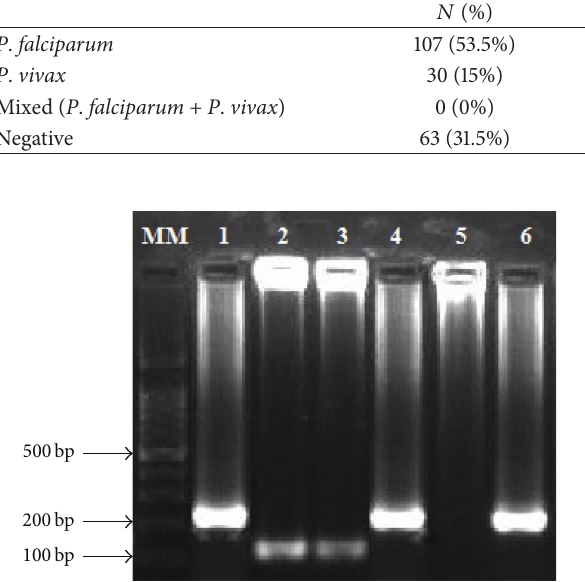
Figure 2: Detection of Plasmodium 18S rRNA gene using nested PCR from Sudanese malaria patients; MM: 100 bp ladder (iNtRON Biotechnology, South Korea), 1, 4, 6: P . falciparum, 2, 3: P . vivax , and 5: negative